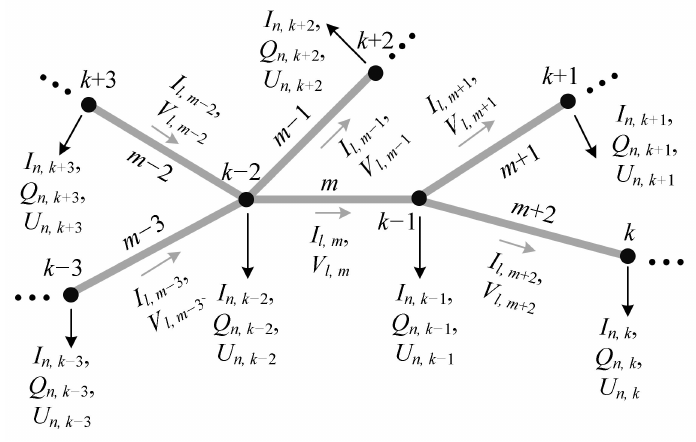
Figure 1. Variable distribution along the thin-wire